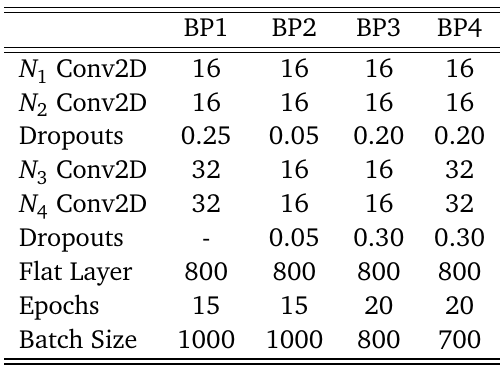
, i = 1,..4 represents i